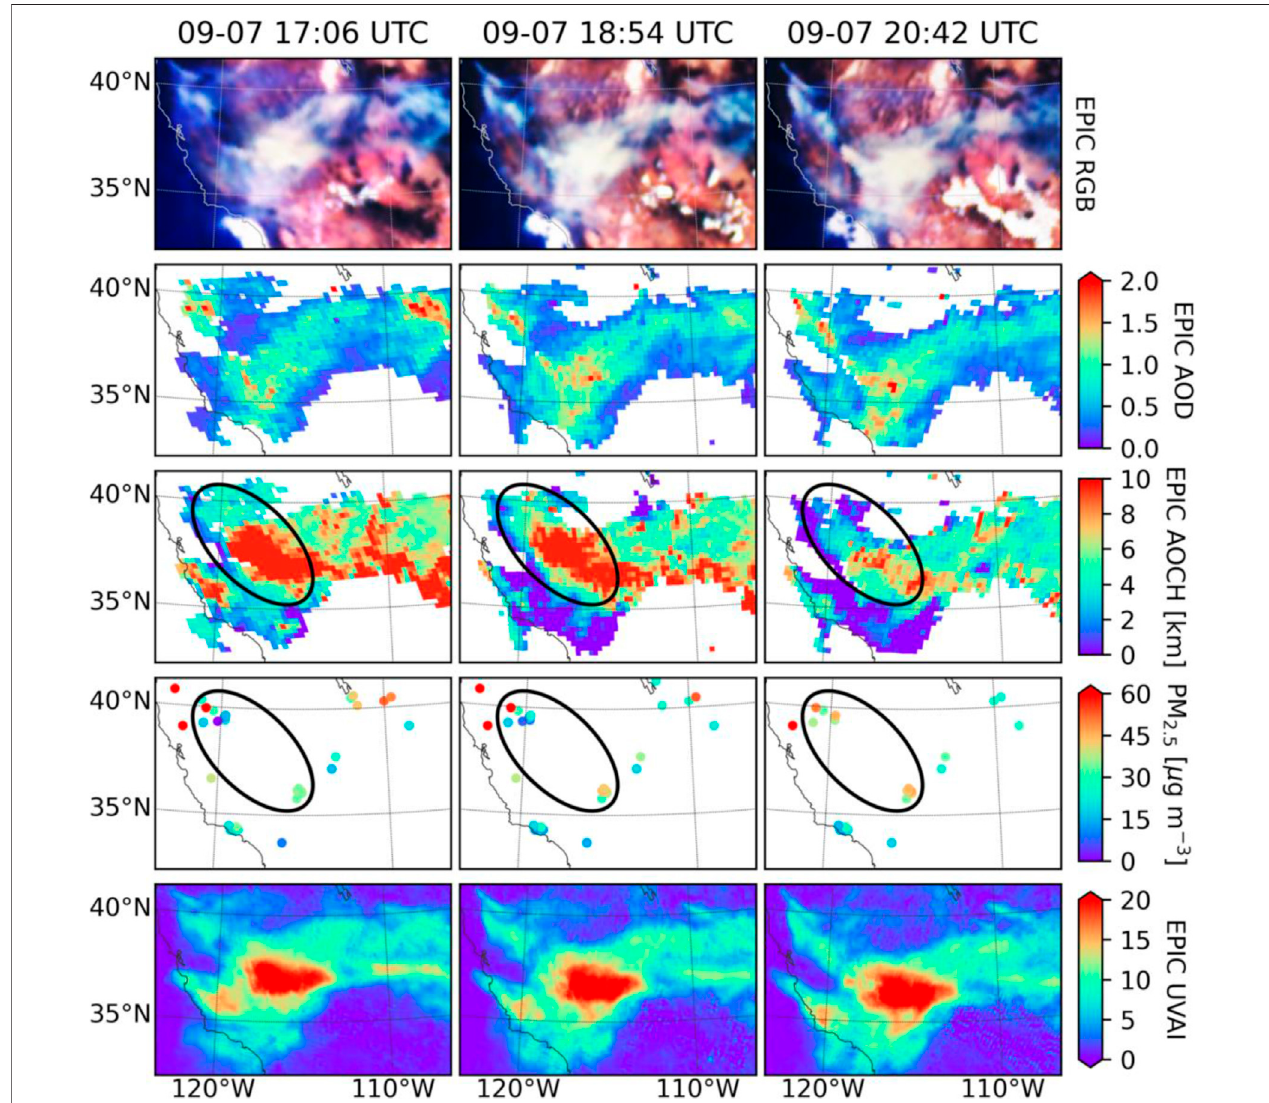
FIGURE 6 | Diurnal variation of EPIC AOCH and its implication on surface PM 2.5 concentration from 17:06 to 20:42 UTC on September 7, 2020. The fi rst row is EPICtruecolorimage,andthesecondrowistheEPICAOD.ThethirdrowistheEPICAOCHretrievals,andthefourthrowistheEPAsurfacePM 2.5 massconcentrations at 17:00, 19:00 and 21:00 UTC respectively. The last row is EPIC UVAI.